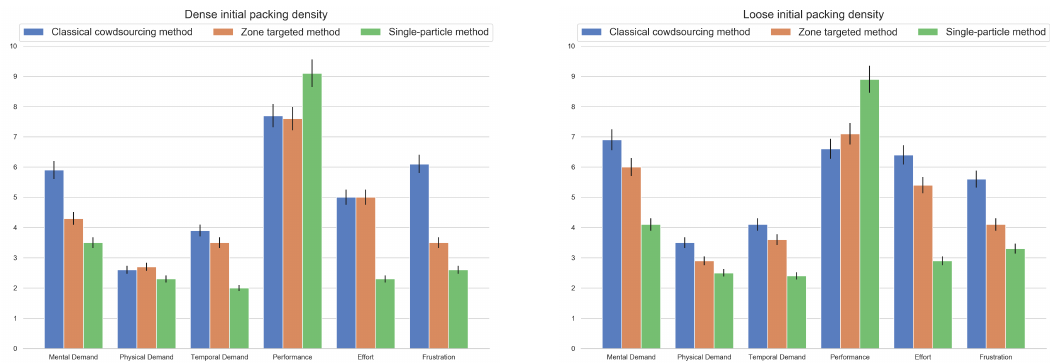
Figure 9. NASA Task Load Index (TLX) plot for the classical method (blue bar, left-hand side in each triple post), zone-targeted crowdsourcing method (orange bar, middle position in each triple post) and the single-particle focused crowdsourcing method (green bar, right-hand side in each triple post) for two initial silo filling conditions, i.e., dense (left) and loose (right) initial packing